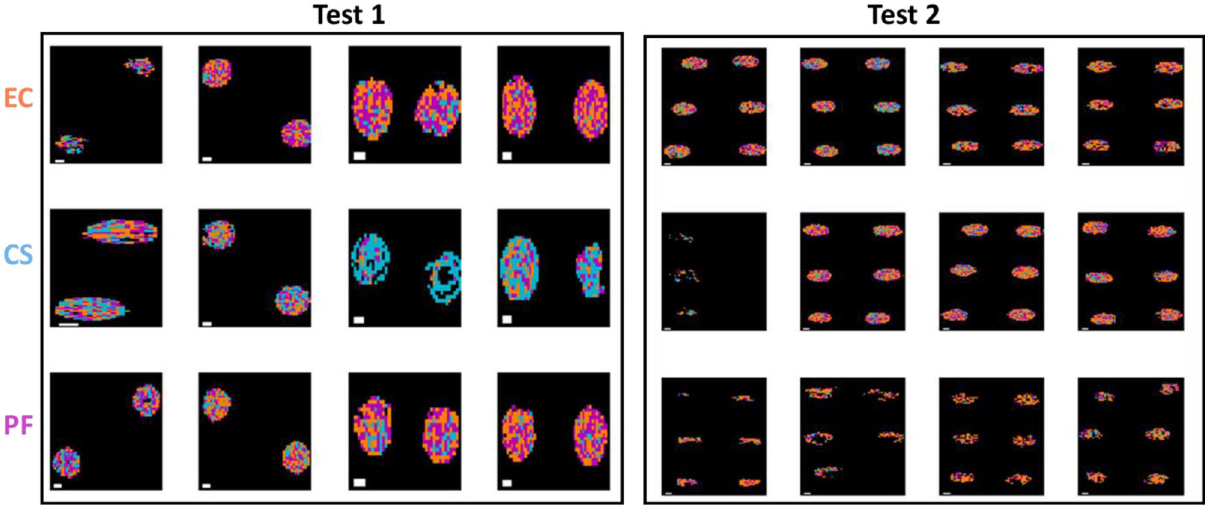
Figure 9. Classification maps for samples in the test set (reps 6, 9, 12, and 16) obtained from the best pixel level VNIR/SWIR models for GN species EC/CS/PF classification (pixels classified as EC/CS/PF are shown in orange, blue or magenta respectively). Each replicate has two drops. EC: Escherichia coli , CS: Cronobacter sakazakii ; PF: Pseudomonas fluorescens. White scalebar indicates 1 mm (width) × 0.2 mm (height).